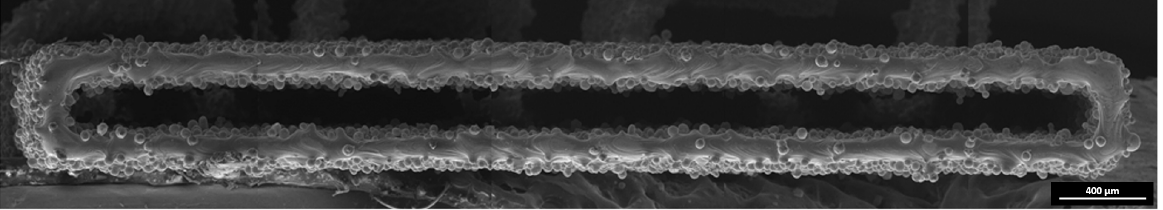
Figure 5. Thin-walled tube of a rectangular section built in experiment number 9 (80 W/300 mm/s).